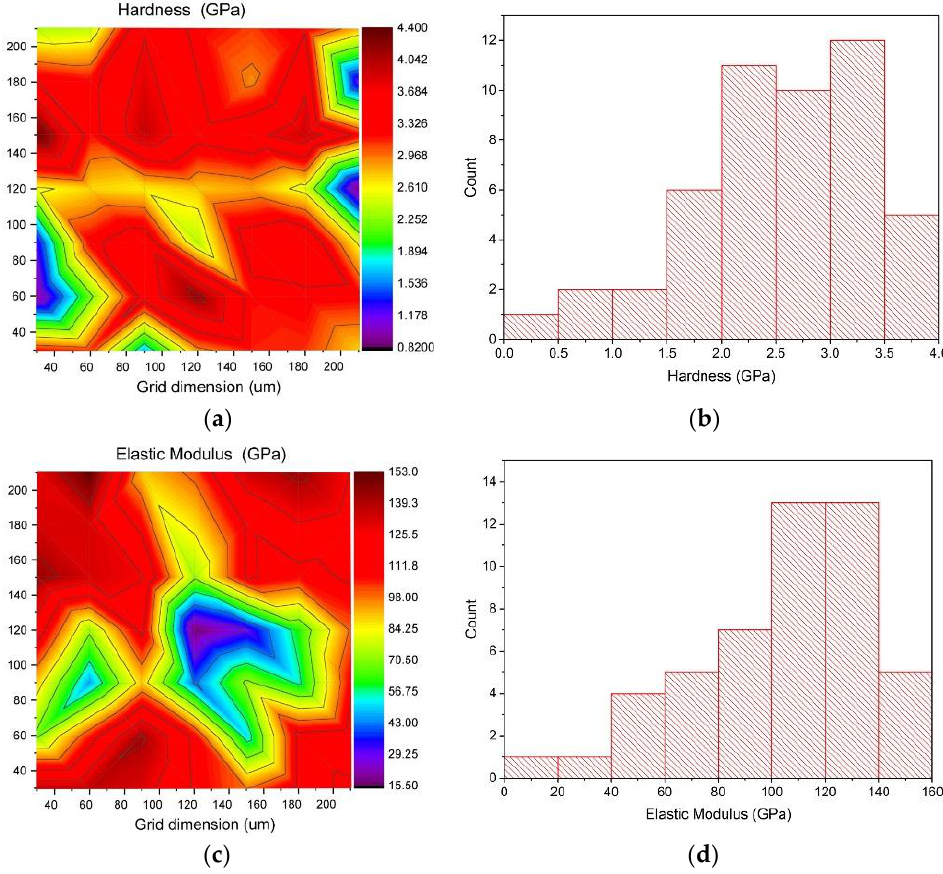
Figure 8. Distribution of the mechanical properties for a Ti coating deposited at a standoff distance of 20 mm: ( a ) hardness map, ( b ) hardness histogram, ( c ) elastic modulus map, ( d ) elastic modulus histogram.